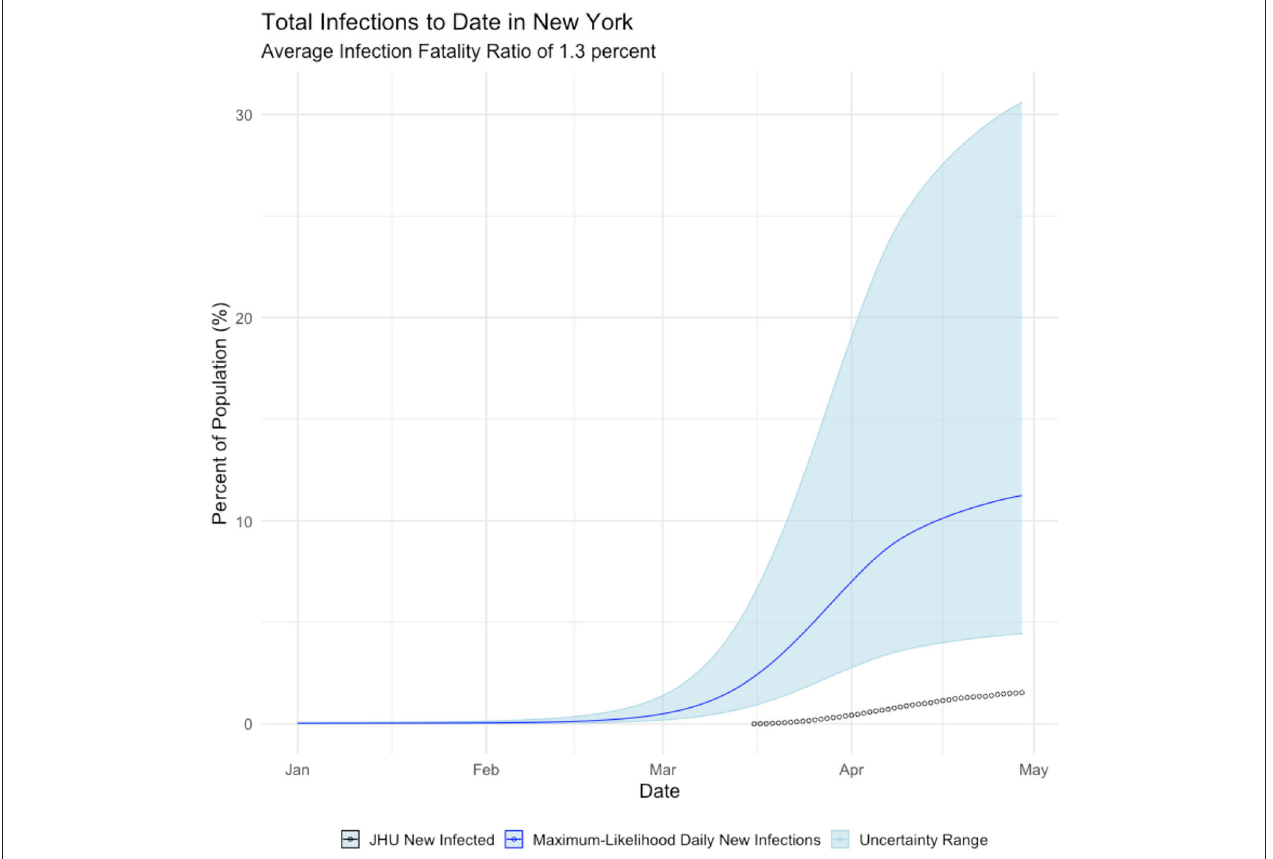
FIGURE 3 | Daily Cumulative Infection count, New York state. Blue line is the maximum-likelihood estimate of daily new infections. Black circles are observed cases counts.